Question: What caption would you write for this figure?
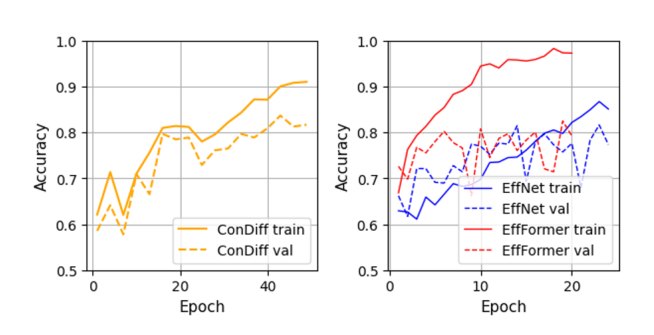
Answer: The learning accuracy trajectories of the ConDiff classifier and best-performing CNN-based (EfficientNet-B0) and ViT-based (EfficientFormer-L1) models, on the train and validation sets.